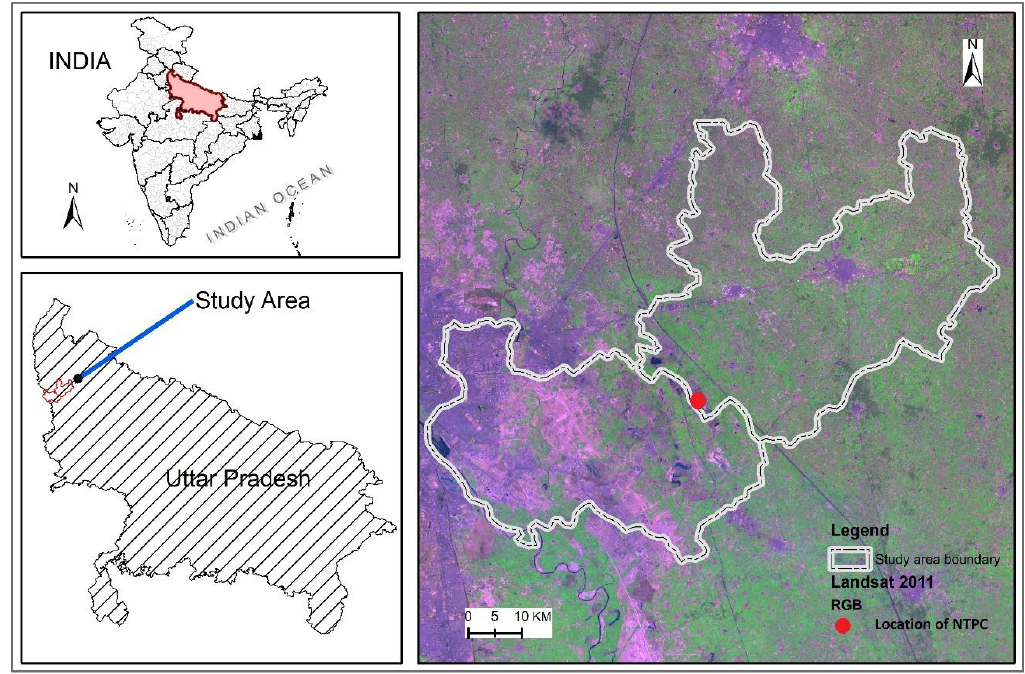
Figure 1. Location of the study area (yellow pointer shows location of National Thermal Power Corporation (NTPC) Dadri).